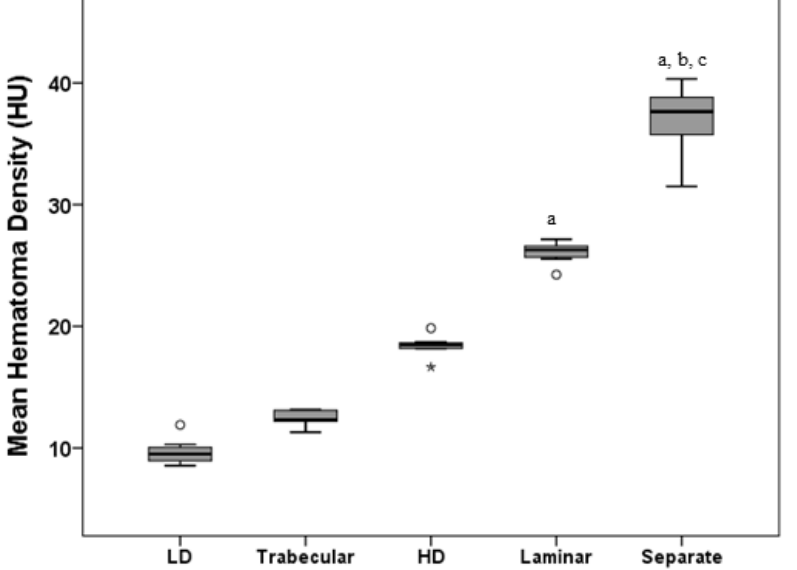
Figure 4. The distribution of MHD across five types of CSDHs based on internal structure. A significant difference was found using Dunn’s post-hoc test after a Kruskal–Wallis test. a p < 0.05 compared to LD; b p < 0.05 compared to trabecular; c p < 0.05 compared to HD. Note: Values more than three IQRs from the end of a box are labeled as extreme, denoted with an asterisk (*). Values more than 1.5 IQRs but less than 3 IQRs from the end of the box are labeled as outliers